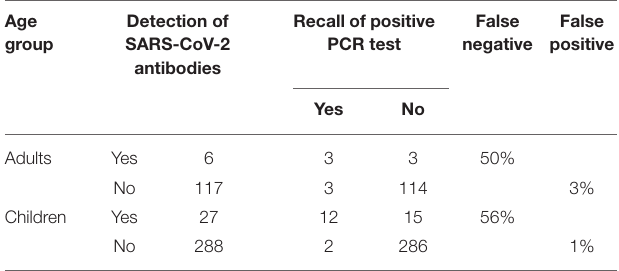
FIGURE 4 | Timeline of testing: Gray bars denote the daily 7-day incidence/100,000 in Bavaria. The vertical yellow lines reflect the days of PCR testing in Phase I, II and III, respectively. Days with positive PCR test results for SARS-CoV-2 are marked by purple lines.